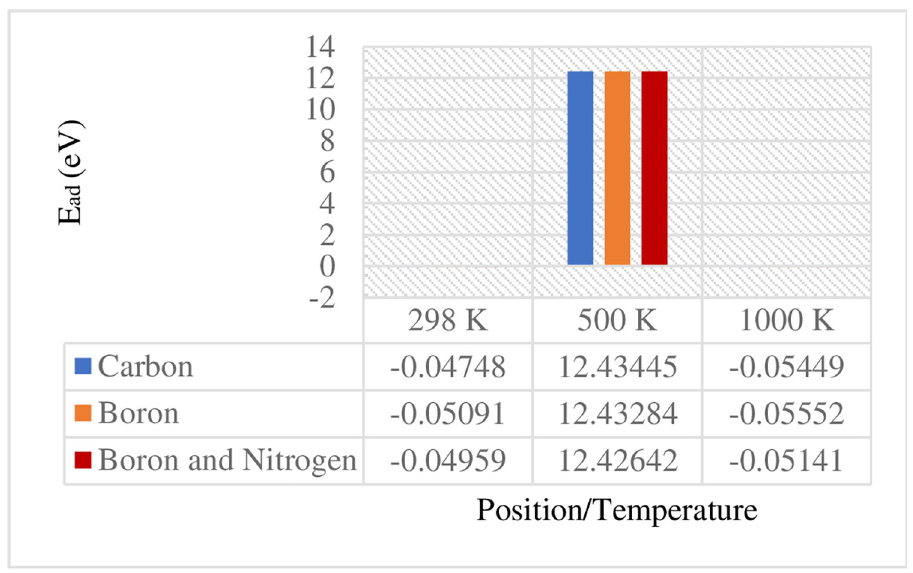
Fig 11. Comparison of the adsorption energy for 12-BC 2 NNR at three different temperatures.